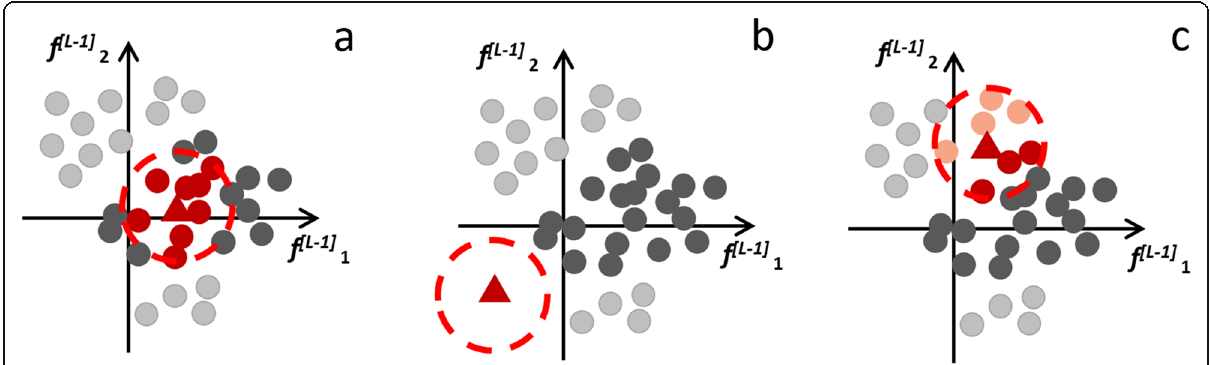
Fig. 4 Possible instances of location of the current case (CC) in the feature space. a The current case (red triangle) falls into a region crowded with annotated cases (ACs), supposed to be equally classified with high confidence (red circles). b The CC falls into an uninhabited region, which would highlight a lack of training or validation similar cases. c The CC falls into a crowded region, yet with different classifications of ACs (red and orange circles), most likely with relatively low